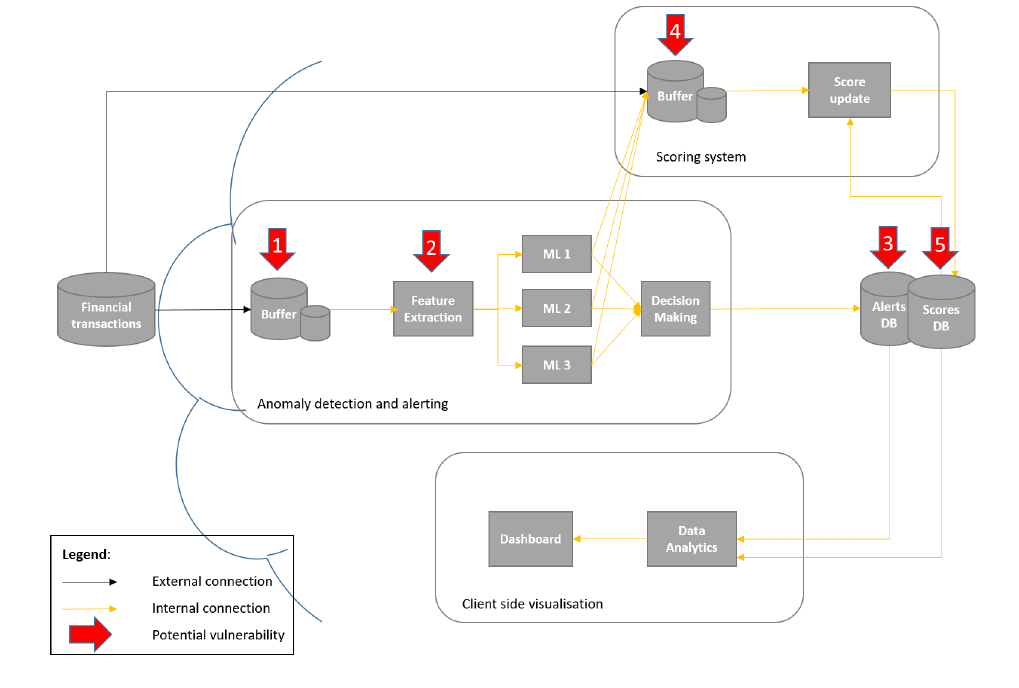
Figure 2. Machine-learning-based scoring module